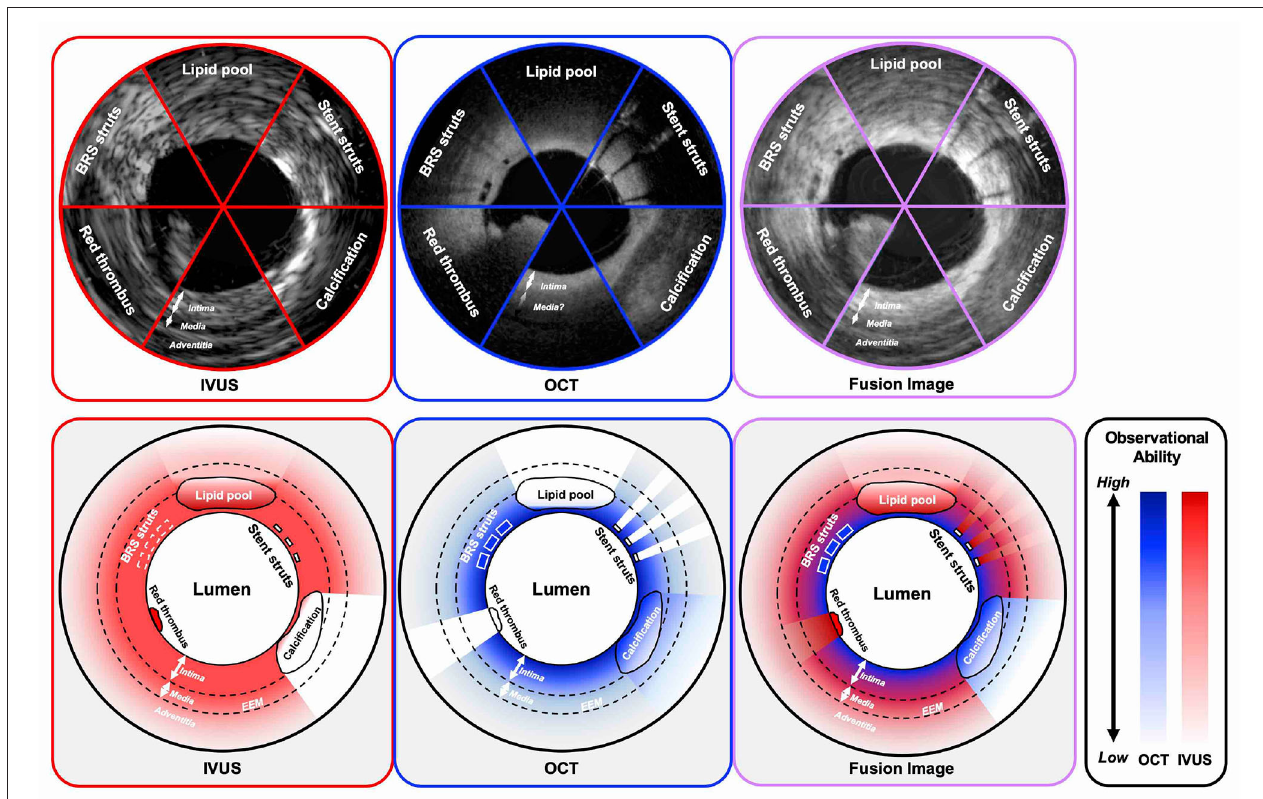
FIGURE 2 | Observational abilities of IVUS and OCT in the settings of several intracoronary structures. IVUS indicates both grayscale IVUS and IVUS with radiofrequency analysis. IVUS, intravascular ultrasound; OCT, optical coherence tomography; BRS, bioresorbable scaffold; EEM, external elastic